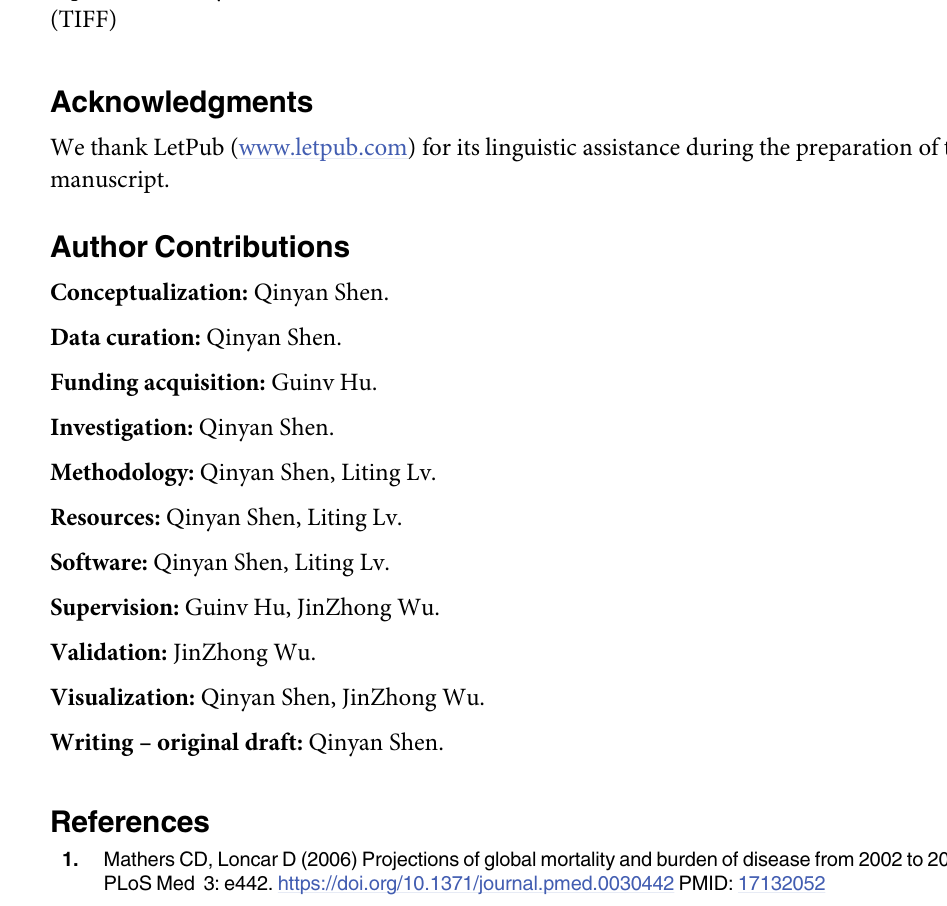
S9 Fig. The calibration curve of survival time at three and five years for liver cancer. Nomogram-predicted probability of survival time is plotted on the x-axis; actual survival time is plotted on the y-axis.